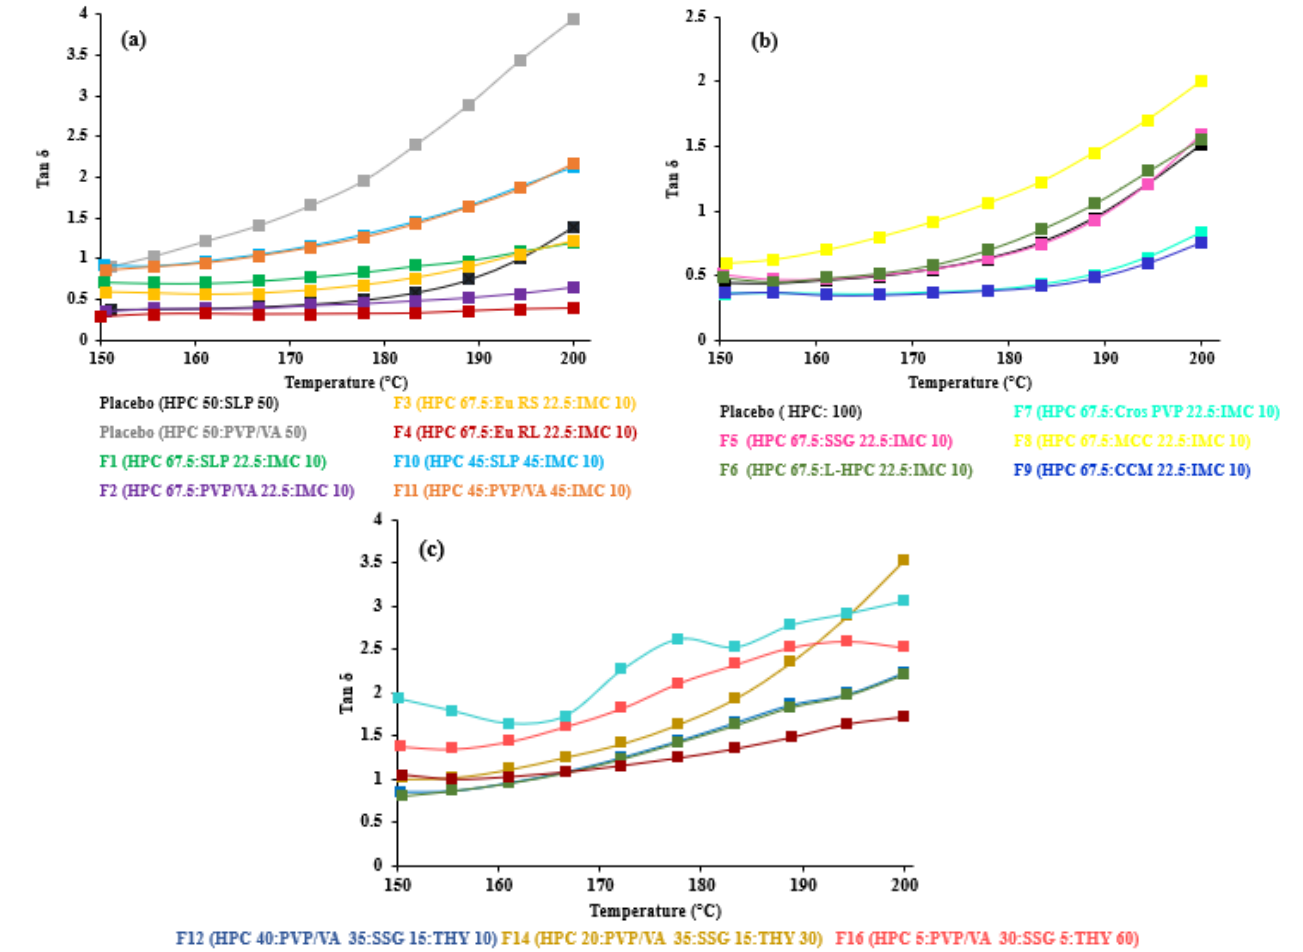
Figure 4. Tan delta vs. temperatures of ( a ) 67.5–45% HPC:polymer mixtures, ( b ) 67.5% HPC: disinte-